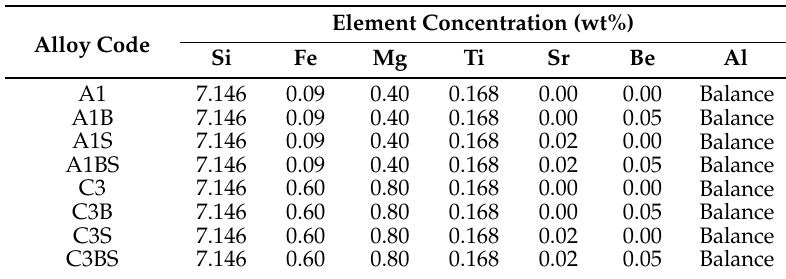
Table 1. Nominal chemical composition (wt%) of the 356 and 357 alloys studied.